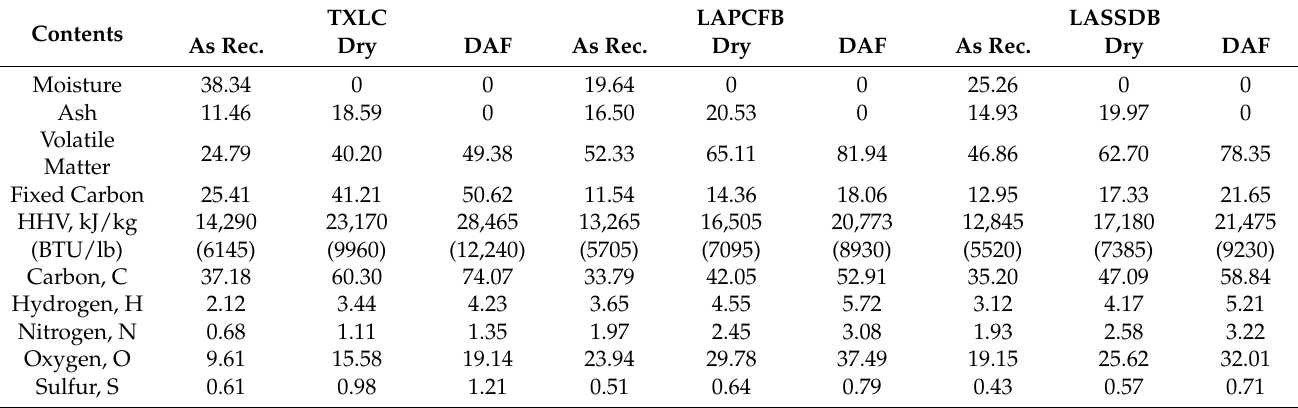
Table 2. Proximate and ultimate analyses for reburn fuels. Natural gas: CH 4 —94.3%, CO 2 —1.7%, C 2 H 6 —2.4%, N 2